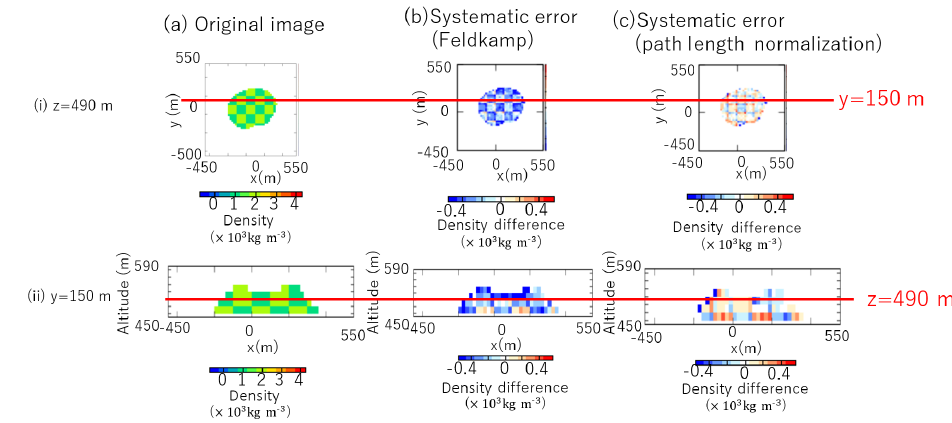
Figure 7. A comparison of the Feldkamp approximation and path length normalization approximation. Table 1. The relationship among the number of observation points, systematic error deviation σ sys (kgm − 3 ) and mean accidental error µ acc (kgm − 3 ) on each “ z ” cross section. The number of observation points